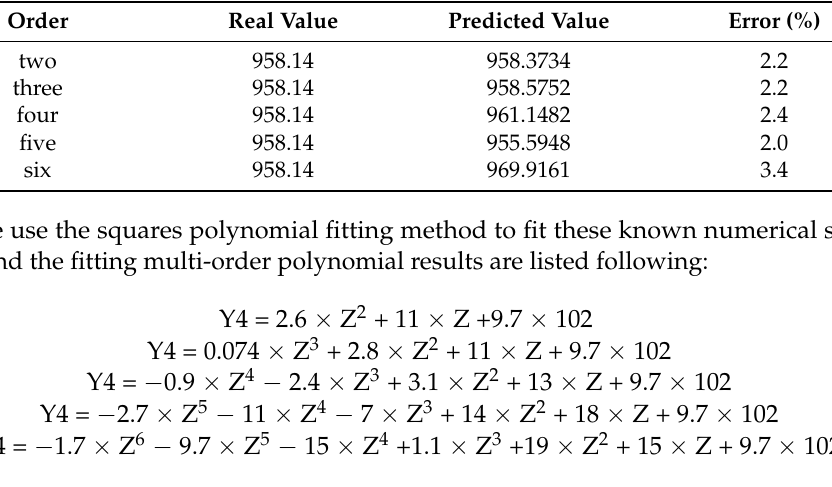
Table 5. The error of different multi-order polynomial for